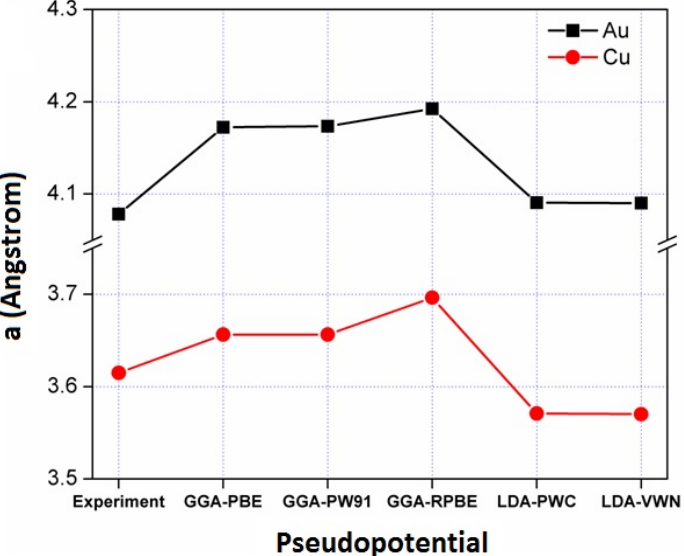
Figure 1. Optimization findings of Au and Cu using various pseudo-potentials.